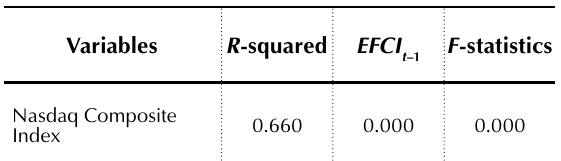
Table 4. Regression statistics